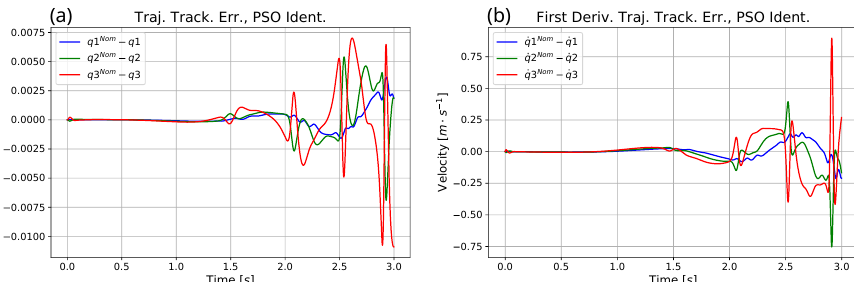
Figure 11. Trajectory tracking error ( a ) and its first time derivative ( b ) during the parameter identifi- cation process.